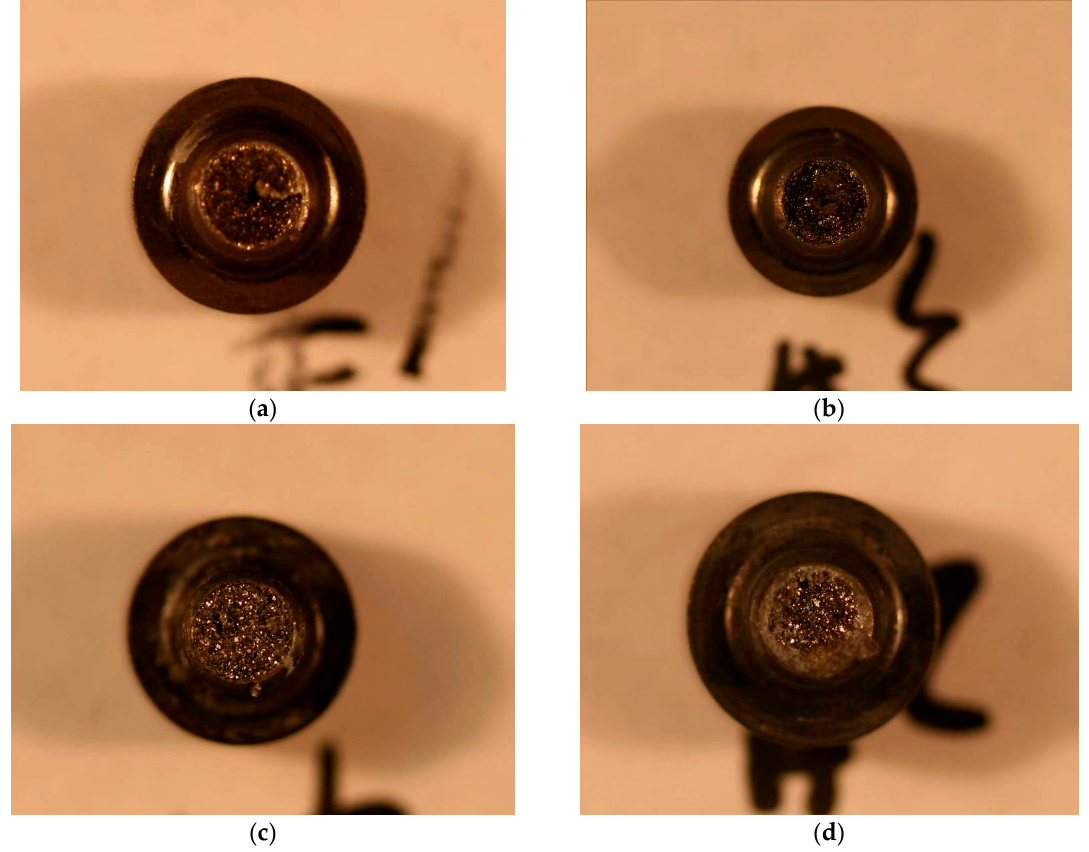
Figure 2. Fracture surface macro appearance of the ( a ) #1; ( b ) #2; ( c ) #3; and ( d ) #4 screws.